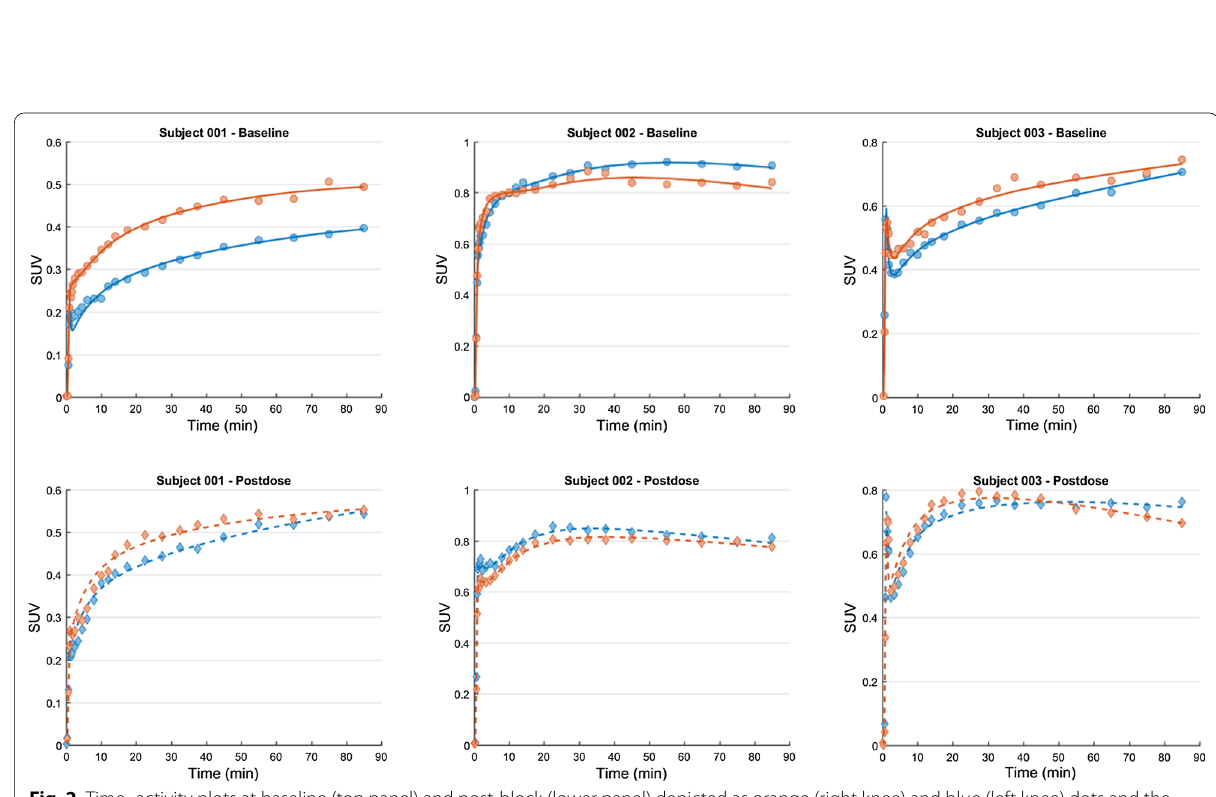
Fig. 2 Time–activity plots at baseline (top panel) and post-block (lower panel) depicted as orange (right knee) and blue (left knee) dots and the model fit as continuous lines to the output data using the 2TC model for all the subjects